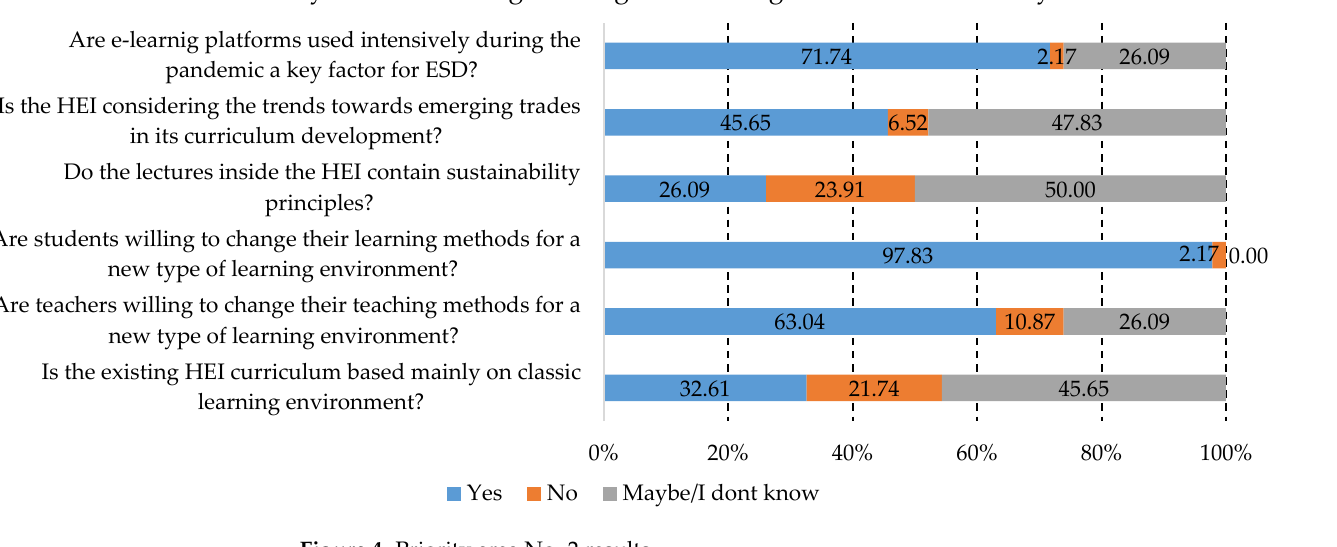
Figure 4. Priority area no.2 results.